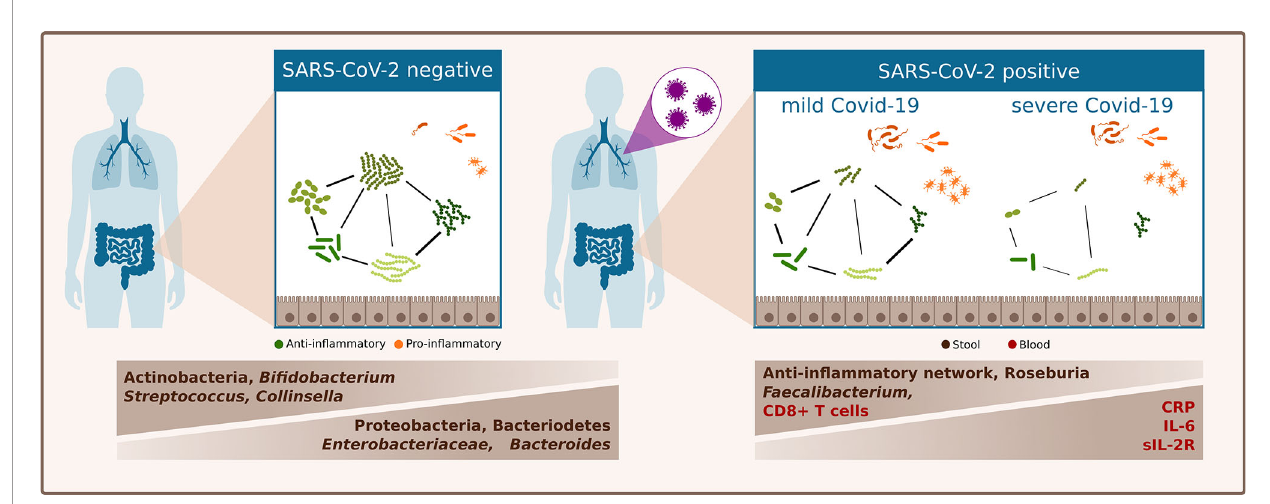
FIGURE 3 | Schematic summary of differences of the gut microbiome linked to SARS-CoV-2 infection and COVID-19 severity